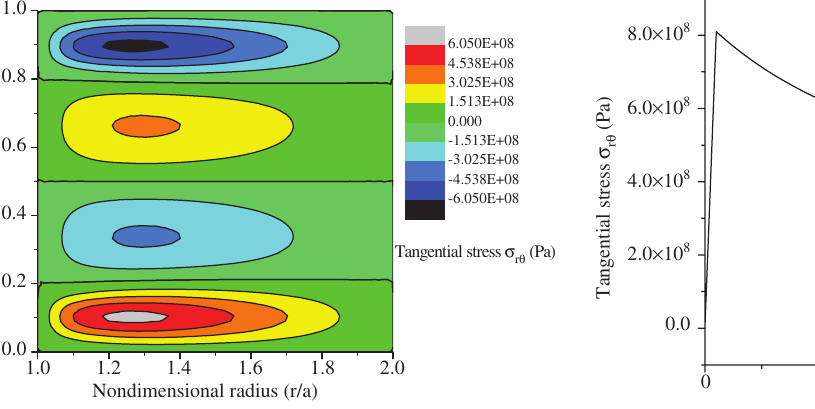
Figure 28 Response histories of tangential stress in the FGM hollow cylinder at location of (0.2625 m, π